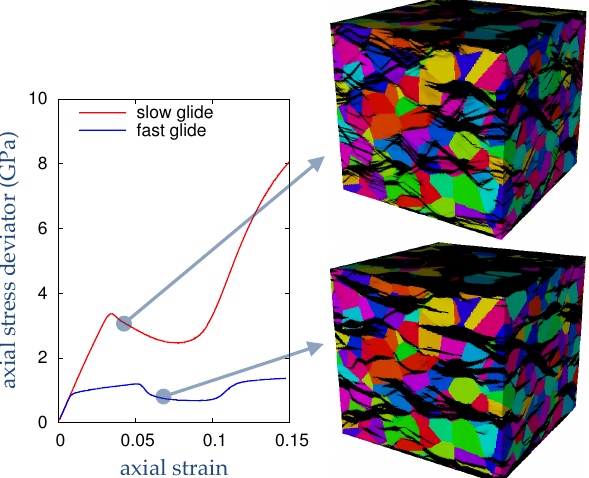
Figure 2. Evolution of the volume-average axial component of the deviatoric stress; and plots showing the (cid:101) phase morphology, with material that has transformed to (cid:101) plotted in black and colors indicating the parent α grains. The plots are shown at times when there is a similar mass fraction of the (cid:101)